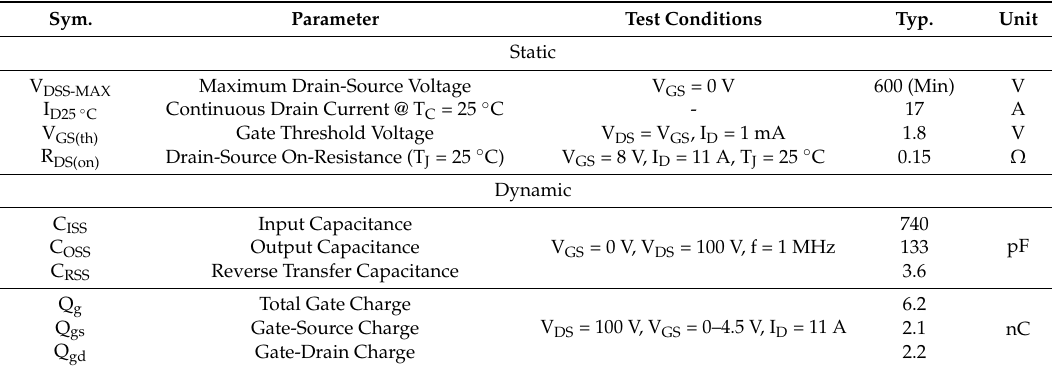
Table A2. A brief datasheet of TPH3006PS.